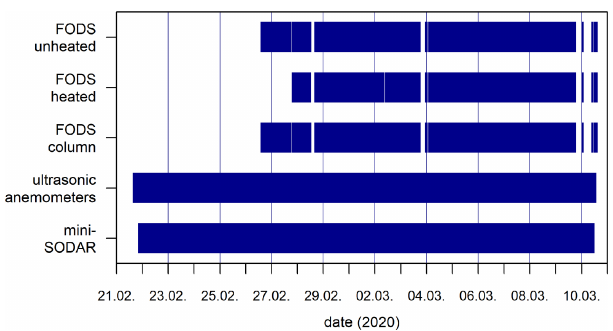
Figure 9. Data availability of the different NYTEFOX data sets for the campaign period in February and March